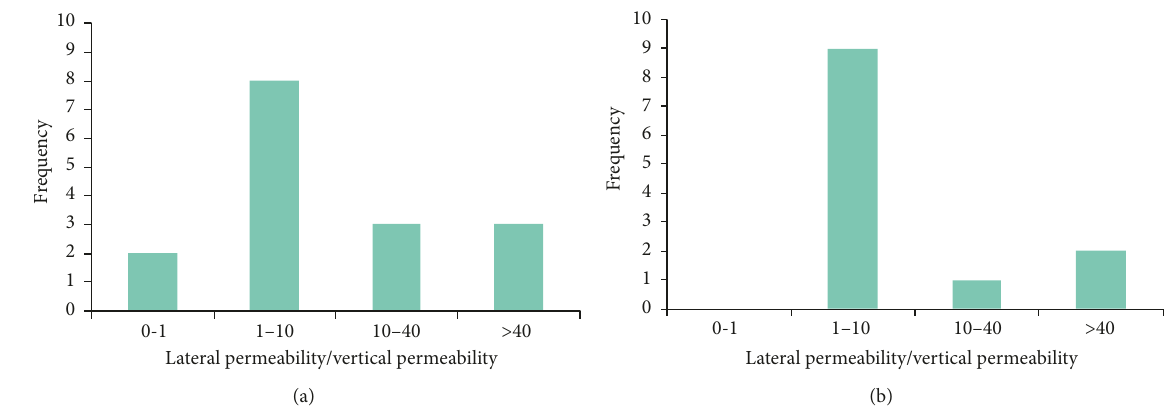
Figure 4: Ratio statistics between lateral and vertical permeability. (a) Samples of the Lower Cambrian shale, from Well JiangYe 1 and JiangYe 2. (b) Samples of the Lower Silurian shale, from Well PengYe 1. See Figure 1 for the well locations.